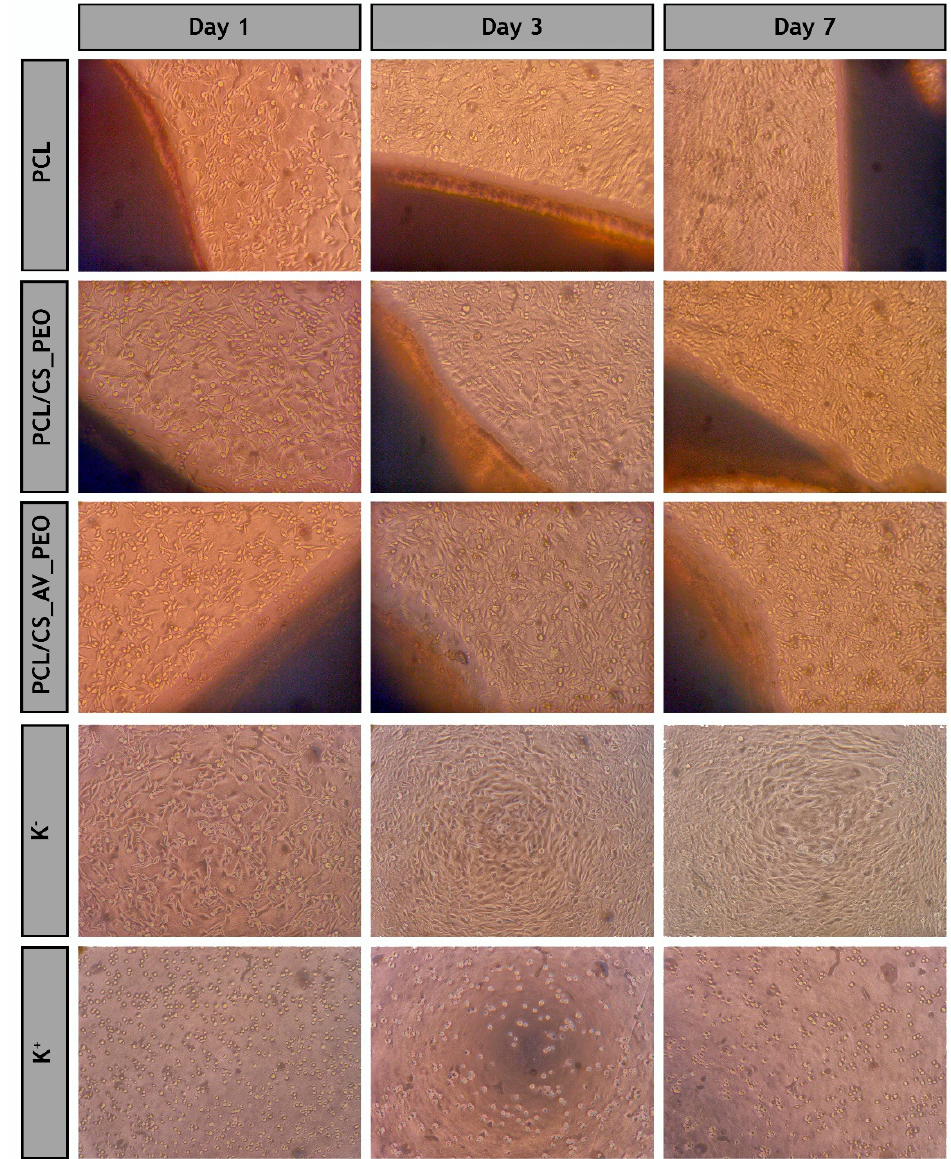
Figure 6. Optical microscopic images of Normal Human Dermal Fibroblast (NHDF) cells in presence of the different produced membranes (PCL, PCL/CS_PEO and PCL/CS_AV_PEO) after 1, 3, and 7 days of incubation; K − (negative control); K + (positive control).